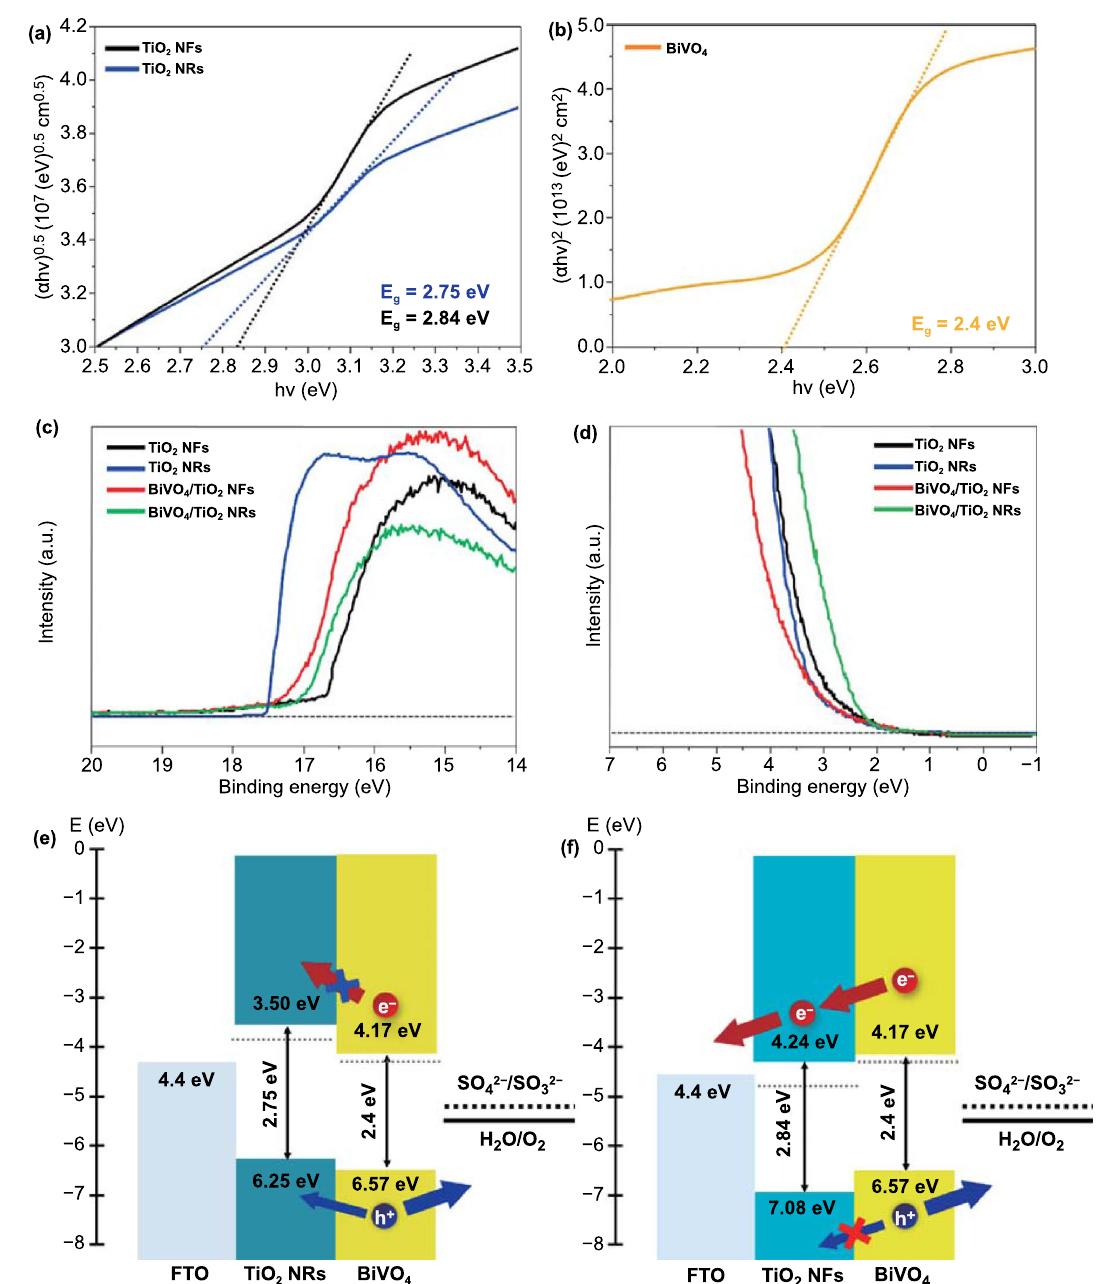
Fig. 6 UV–Vis Tauc plots of a TiO 2 NFs, TiO 2 NRs, and b BiVO 4 . c Secondary electron emission spectra and d valence band spectra of TiO 2 NFs, TiO 2 NRs, BiVO 4 /TiO 2 NFs, and BiVO 4 /TiO 2 NRs. Flat band structures of e BiVO 4 /TiO 2 NRs and f BiVO 4 /TiO 2